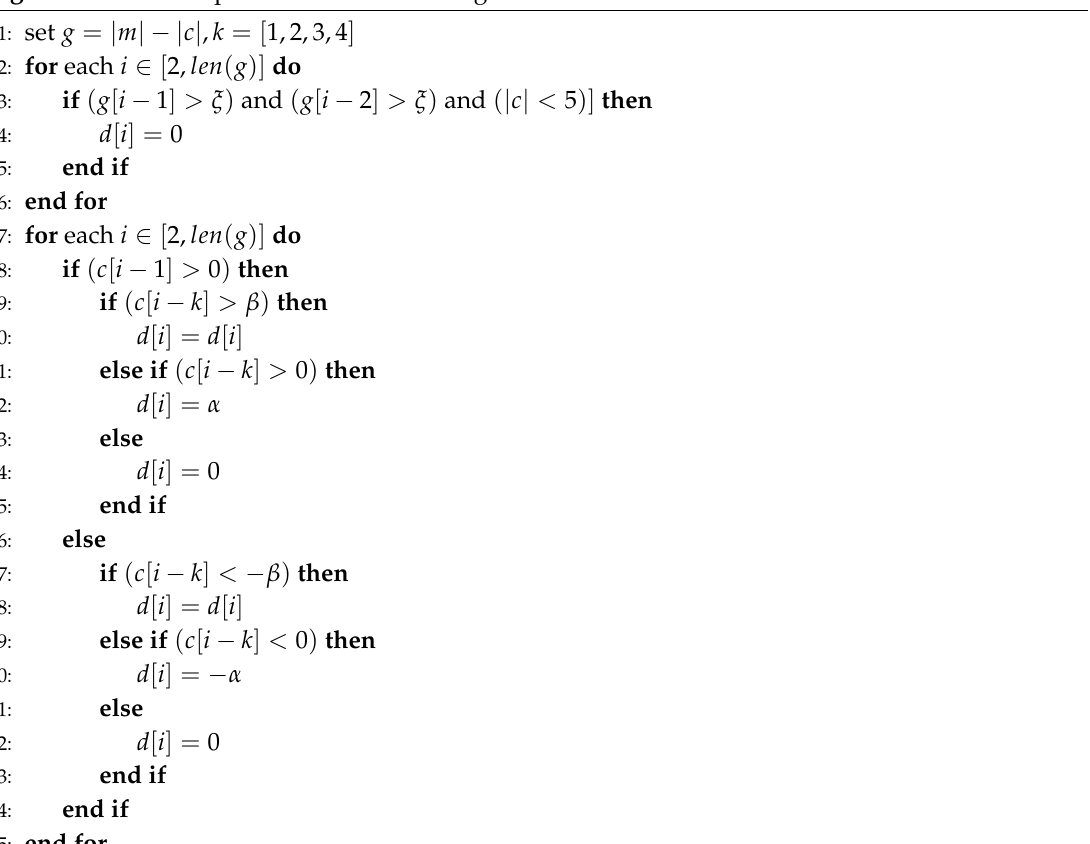
Algorithm 1 The adaptive error correction